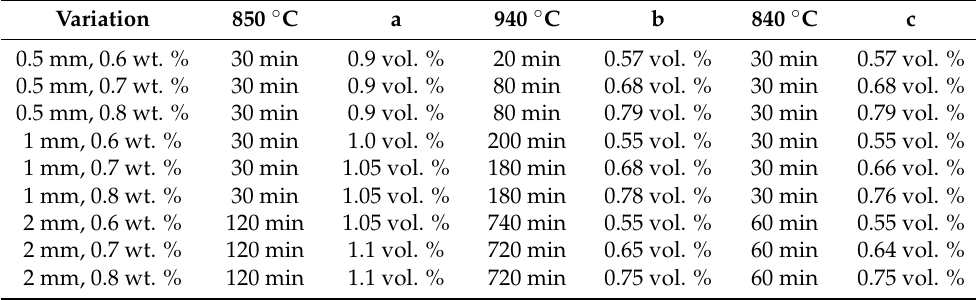
Figure 3. Exemplary process stages for the gas carburizing; details about the varying parameters are given in Table 3. Table 3. Holding times at the different temperatures and carbon potential in the atmosphere for the different heat treatment